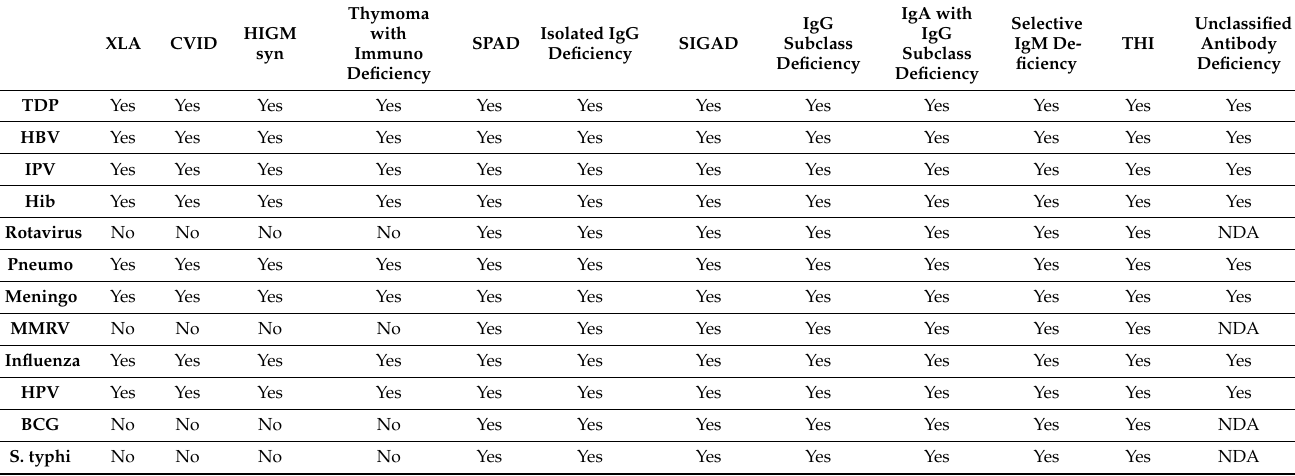
Table 1. Recommendations for Vaccinations in Antibody Deficiency Disorders